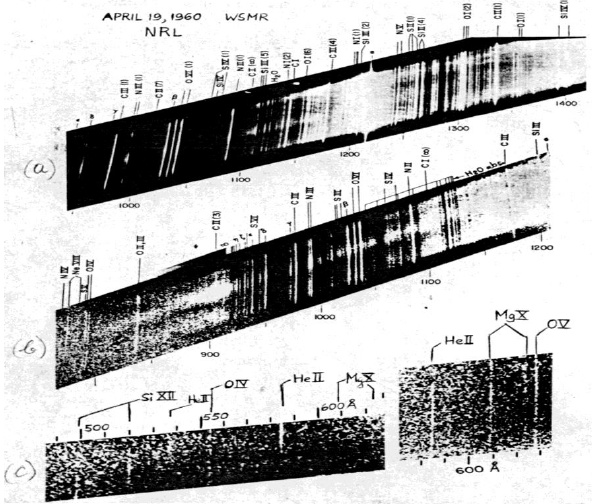
Figure 5: Photographic Spectrograms in the EUV spectral region 140-50 nm (Detwiler, Figure 5. Photographic Spectrograms in the EUV spectral region Purcell, and Tousey, 1961, Copyright permission granted by Société Royale des Sciences de 140–50nm (Detwiler, Purcell, and Tousey, 1961; copyright permis- Liège): (a) 60 sec. exposure, (b) 60 sec. exposure, (c) short wavelength sections of same sion granted by the Société Royale des Sciences de Liège): (a) 60s exposure as (b), produced by first order pre-dispersion (right) and second order (left), exposure, (b) 60s exposure, (c) short wavelength sections of same respectively (Tousey, 1963, Copyright permission granted by Springer). exposure as (b) , produced by first-order predispersion (right) and second-order predispersion (left), respectively (Tousey, 1963; copy- right permission granted by Below 50 nm it is extremely difficult to record solar emission spectra with open slits of the spectrophotometer on film because the solar spectral irradiance (SSI) in the VIS is exceeding the one in the EUV by more than six orders of magnitude. Applying the technique of diffraction filters (Schmidtke, 1968) a spectral recording on film was achieved (Schweizer and Schmidtke, 1971; Schmidtke and Schweizer, 1972) covering the XUV (extreme ultraviolet with the soft X-ray region included) from 14.823 nm emission of nickel Ni XI to 21.134 nm emission of iron Fe XIV with a spectral resolution <5 pm. Strong emission lines of iron are presented in Figure 6.